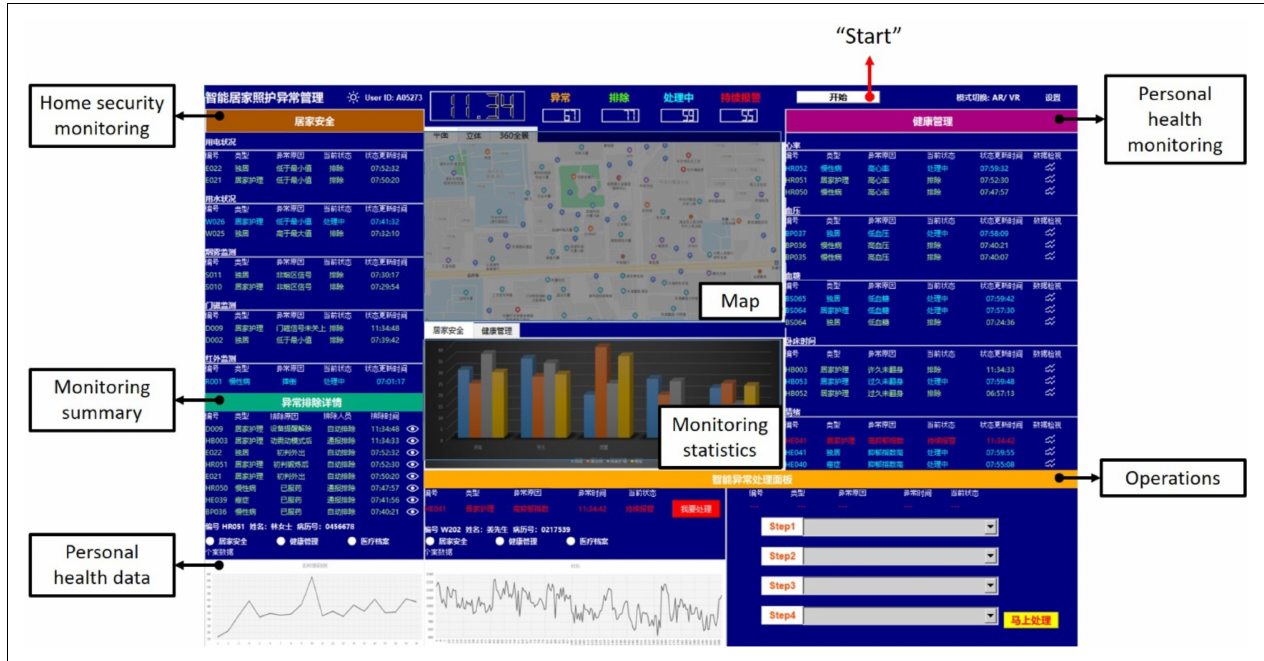
FIGURE 2 | The interface of the smart homecare control